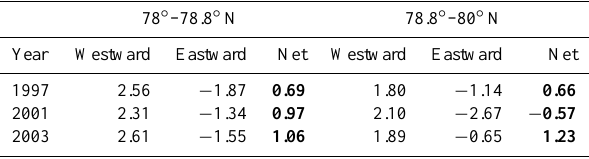
Table 5. Volume transports (Sv) (positive westward) from the meridional (north-south) sections with constraints